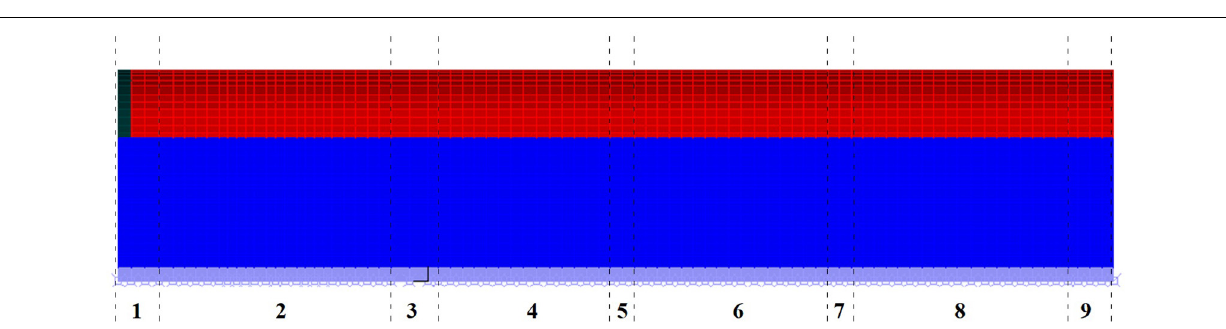
= 5531.263 MPa, f = 6.146 MPa, f = 0.307 MPa; (ii) stone arch t k - E = 11756.332 MPa, f = 13.063 MPa, f tangent k (iii) brick roof - E = 4520.766 MPa, f tangent f t = 0.251